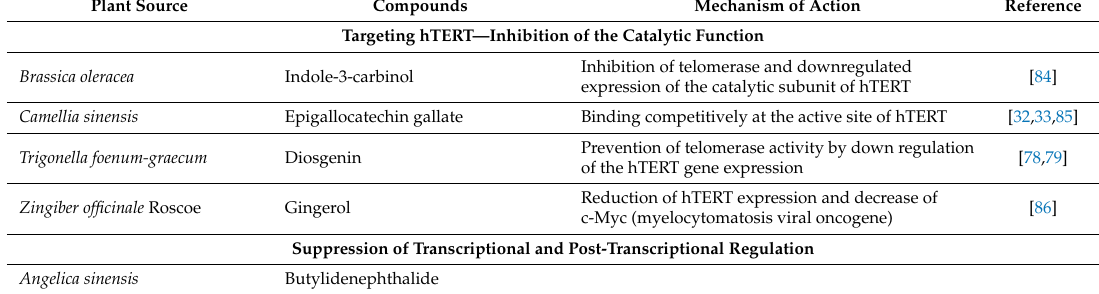
Table 3. Anticancer potentials of natural products from plants on targeting